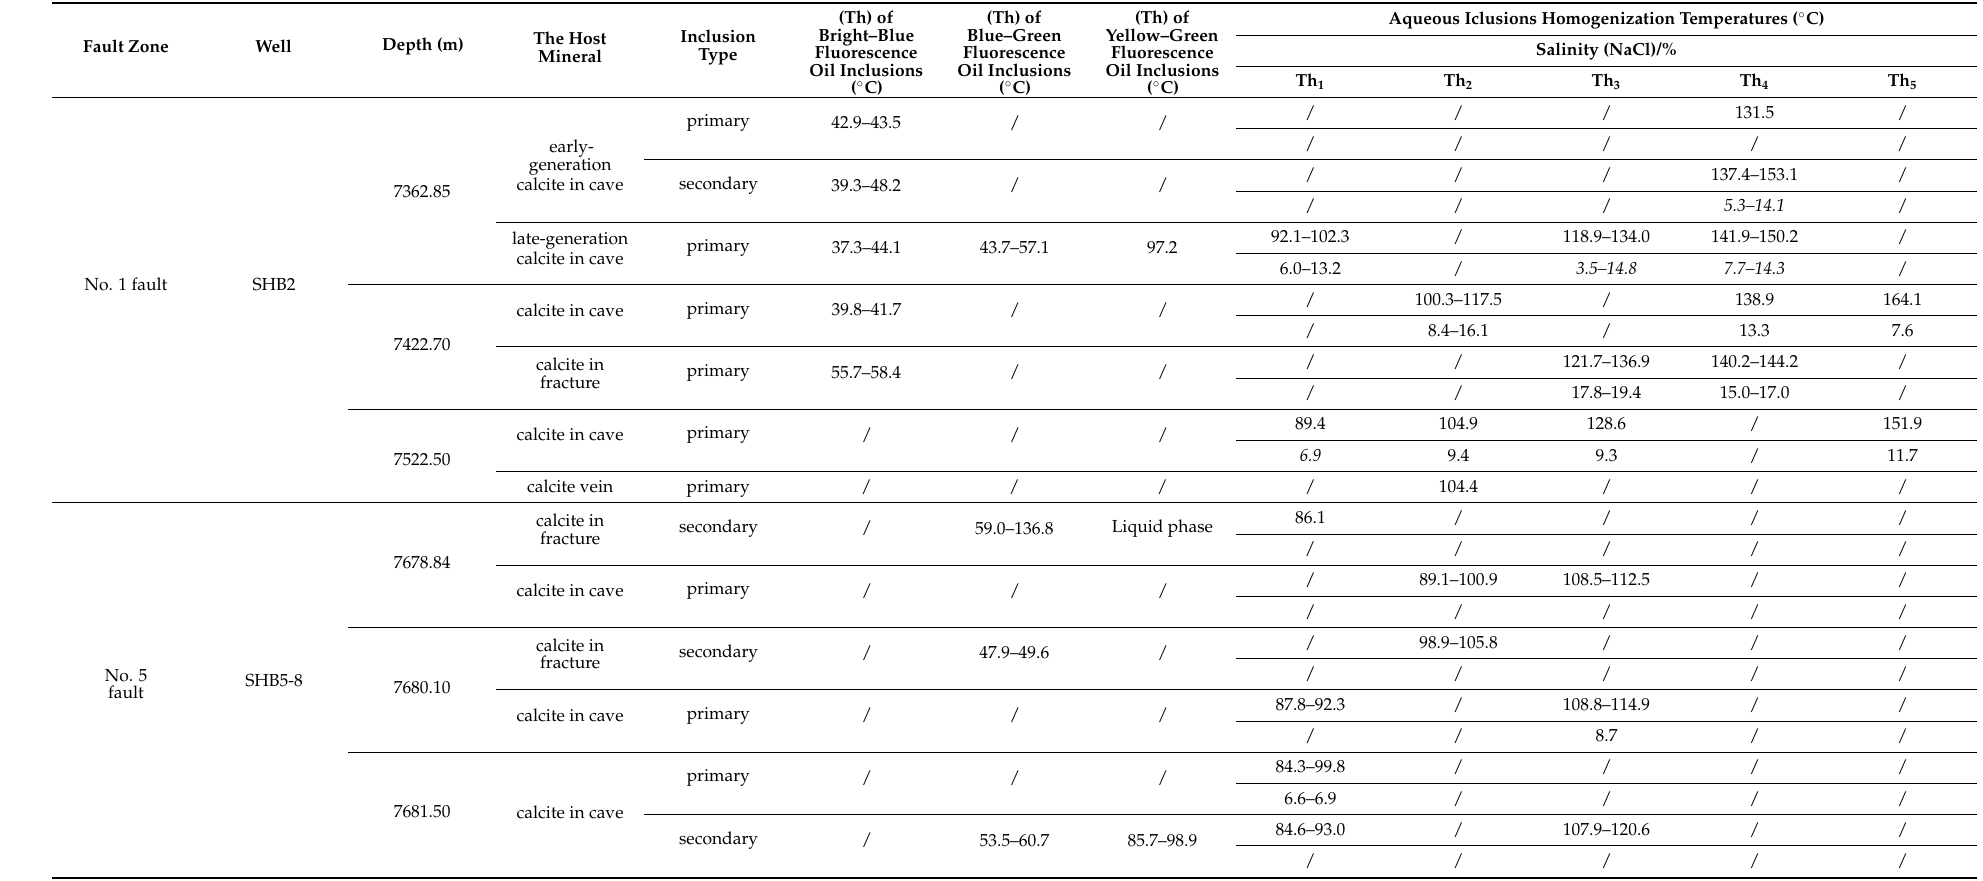
Table 2. Partly fluid inclusion microthermometric data (complete data are shown in Table